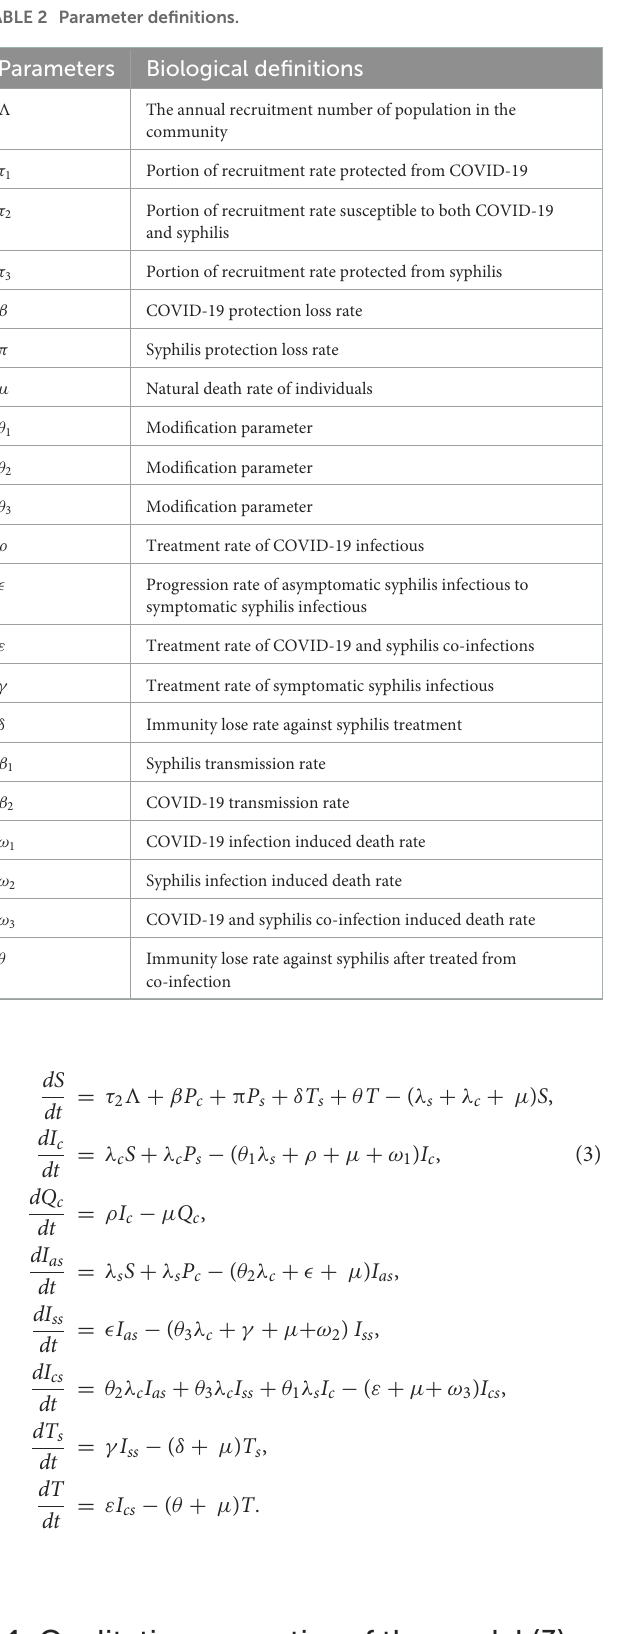
TABLE 2 Parameter